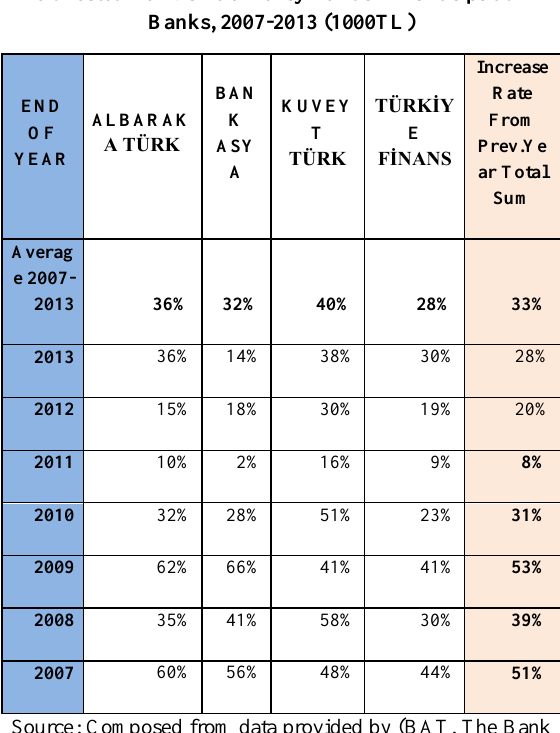
Source: Composed from data provided by (BAT, The Bank Association of Turkey, 2011) (BAT, The Bank Association of Turkey, 2012-13) (PBAT, The Participation Banks Association of Turkey, 2012-13). Table- 7/a: Foreign Currency Funds, 2007-2013 (1.000TL)